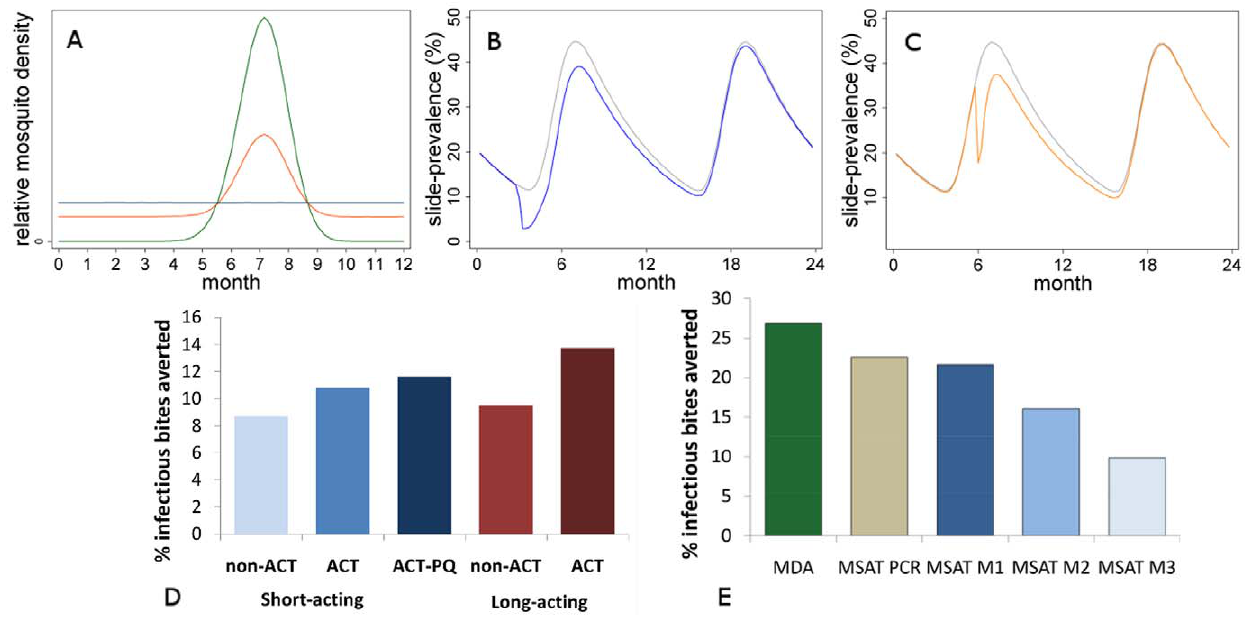
Figure 2. Strategy options for mass treatment. (A) Three scenarios of seasonal mosquito densities simulated by the model: green line=highly seasonal: 96% of infectious bites occur in the peak 3 months; red line=moderately seasonal: 50% of infectious bites occur in the peak 3 months; blue line=not seasonal (for comparison). (B)&(C) Example simulations showing the impact of MDA on slide-prevalence in a scenario of highly seasonal transmission if carried out (B) blue line: prior to the rise in mosquito densities (month 3 in this simulation) as shown in (A), versus (C) orange line: just prior to the peak of the transmission season (month 6 in this simulation). Baseline slide-prevalence in the absence of MDA is shown in gray for comparison. (D)&(E) Model-estimated cumulative % infectious bites averted per person after 1 round of mass treatment over the following 2 years (D) comparing different antimalarial types and (E) comparing different screening criteria used to allocate treatment, in a scenario of moderate transmission intensity (baseline slide-prevalence=15%) with moderate seasonal variation (as in Figure 2A). Mass treatment is carried out prior to the high transmission season. ‘Short-acting’=10 days prophylaxis, ‘long-acting’=30 days prophylaxis. MDA=no screening; MSAT PCR=PCR-positive individuals are treated; MSAT M=microscopy-positive individuals are treated; MSAT M1=microscopy detects all those in the more infectious A and D states in the model and not those in the U state (microscopy sensitivity=58% in the scenario shown); MSAT M2=microscopy sensitivity is 75% for infected individuals regardless of infection state ( D , A or U ); MSAT M3=microscopy sensitivity is 50% for infected individuals regardless of infection state ( D , A or U ).